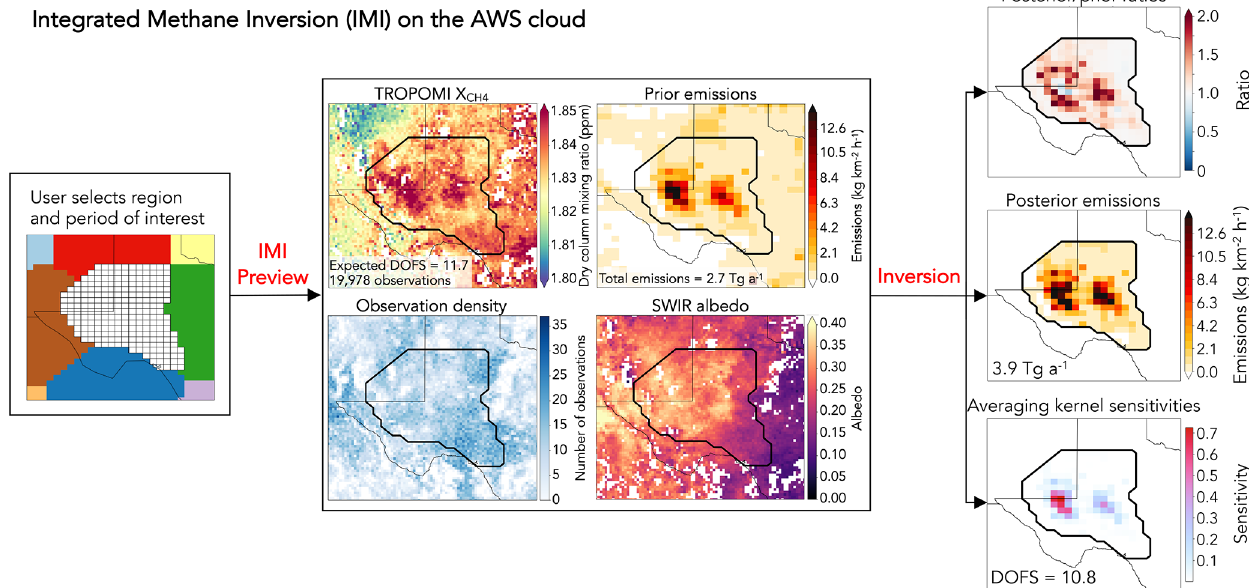
Figure 5. Integrated Methane Inversion (IMI) on the Amazon Web Services (AWS) cloud (Varon et al., 2022). The IMI accesses the TROPOMI operational data posted on the cloud and carries out analytical inversions for user-selected domains and time periods. Before conducting the inversion, users can run an IMI preview to visualize the observations, the default prior emission estimates (to which they can substitute their own), the expected information content of the inversion (degrees of freedom for signal or DOFS), and the SWIR albedos for indication of data artifacts. If the preview is satisfactory, they can then run the inversion to generate posterior emission estimates with averaging kernel sensitivities indicating where the observations can successfully constrain emissions. Shown here is an example given by Varon et al. (2022) for a 1-month (May 2018) inversion over the Permian Basin, using the prior emission estimate from the EDF inventory (Zhang et al., 2020). The IMI is accessible at https://imi.seas.harvard.edu (last access: 23 July